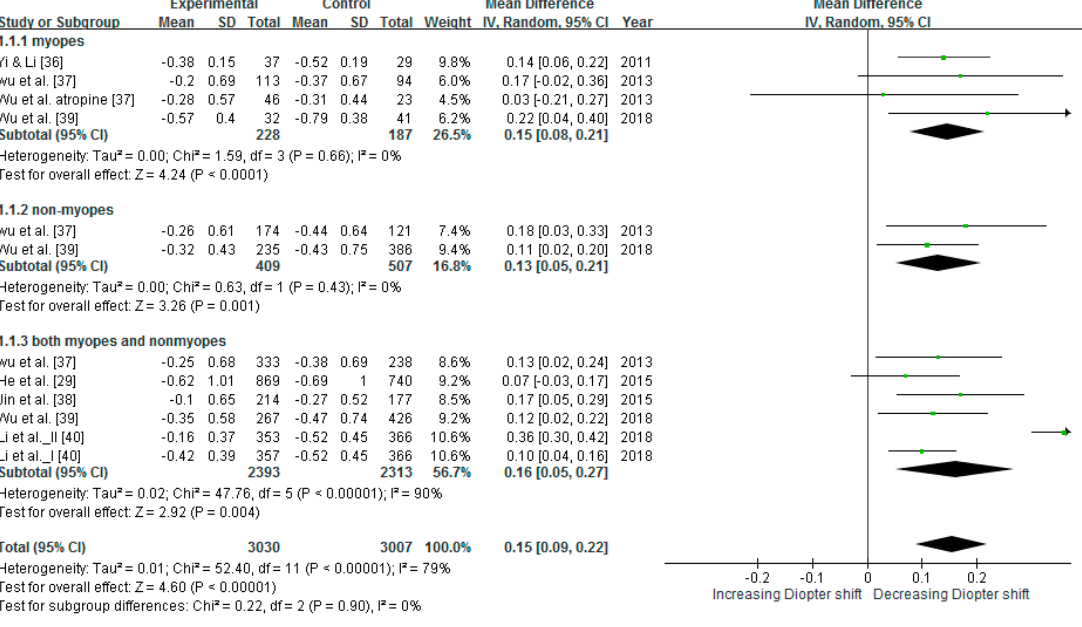
Figure 4. Results of the meta-analysis for axial elongation after intervention.